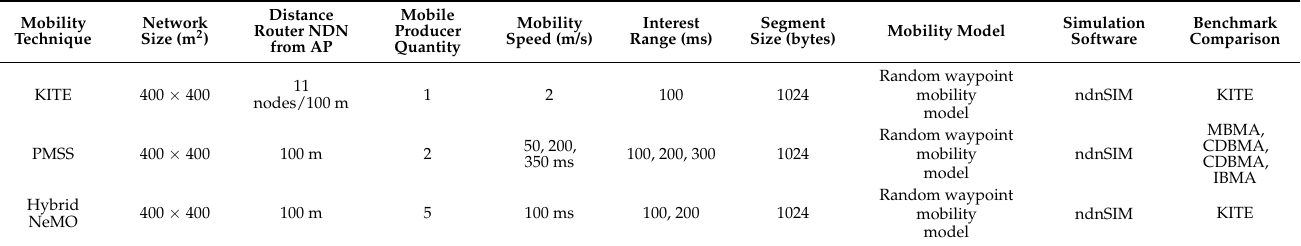
Table 5. Parameter simulation